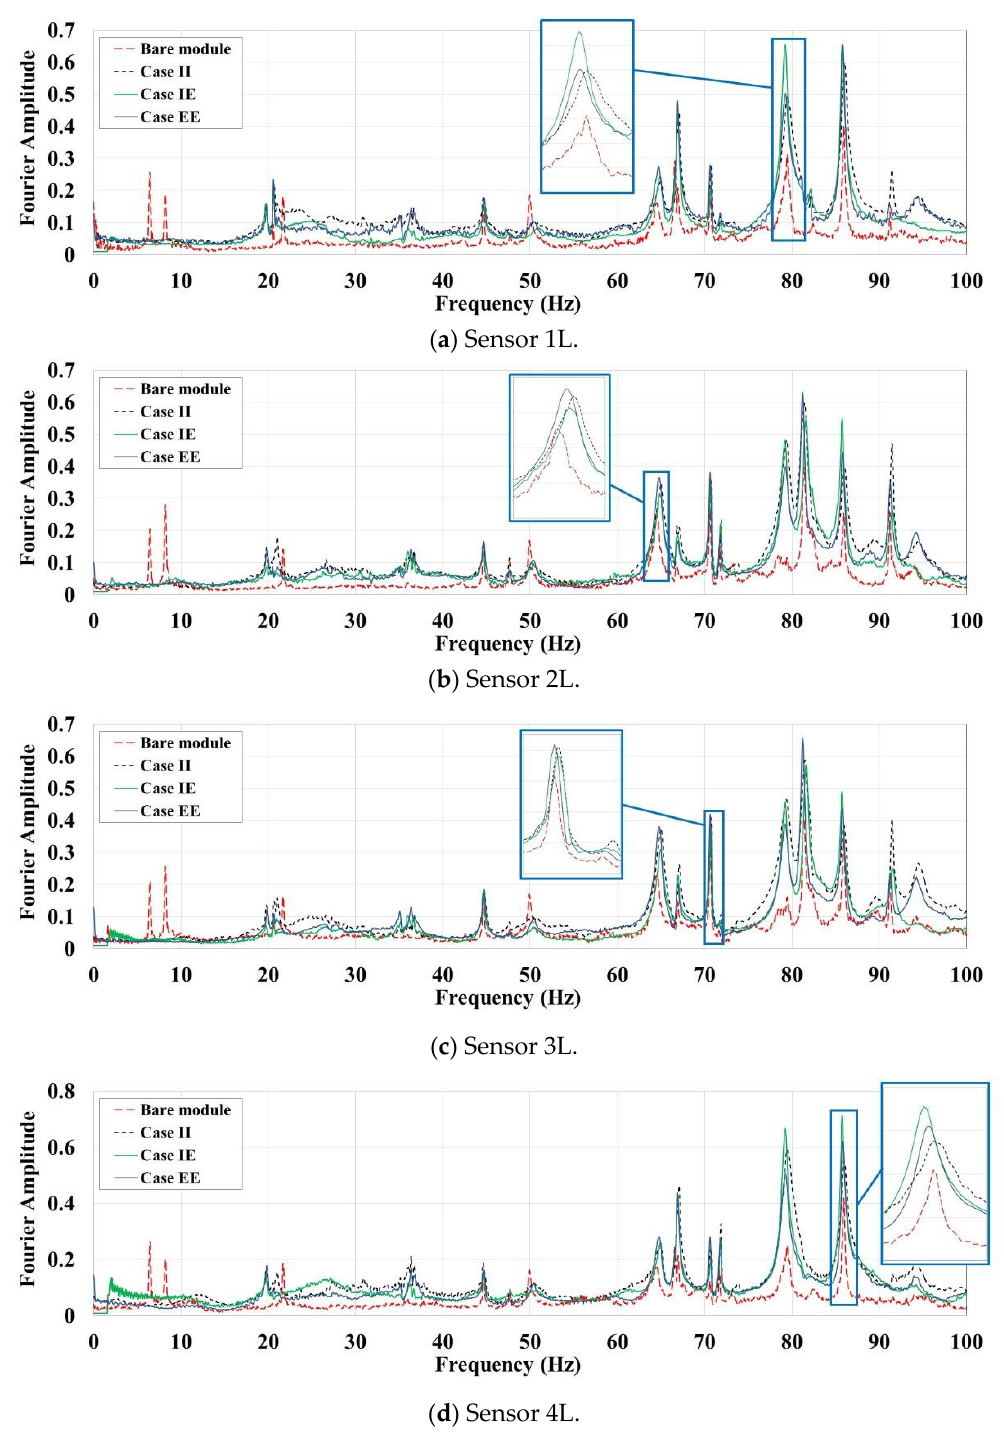
Figure 9. Averaged FFT plots for the L-oriented sensors.